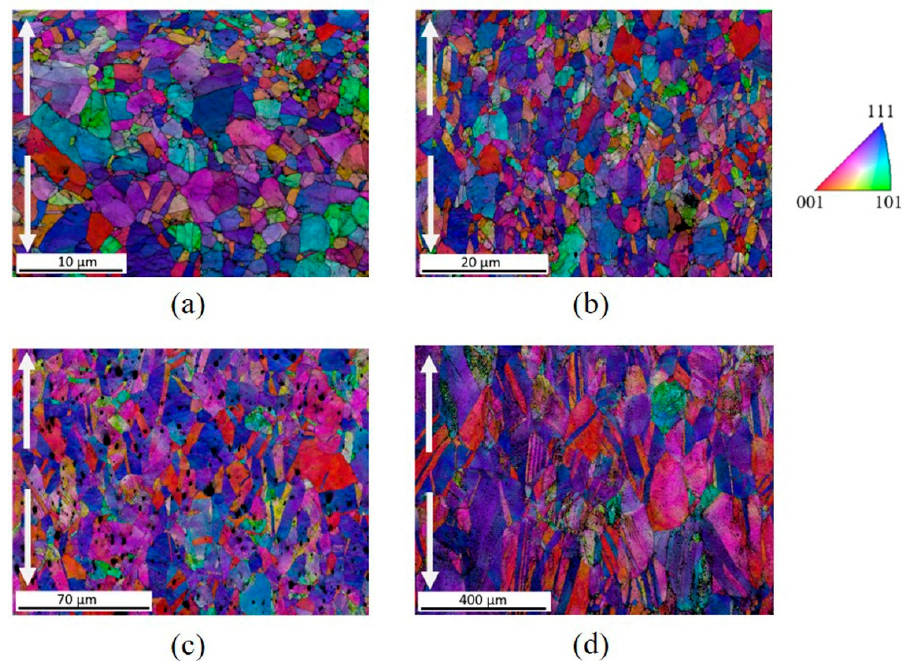
Figure 8. Superposition of inverse pole figure (IPF) + image quality (IQ) cartography for samples 1 (d = 0.82 µm) ( a ), 3 (d = 1.39 µm) ( b ), 4 (d = 4.0 µm) ( c ) and 5 (d = 25 µm) ( d ) with the tensile stress direction as reference, for fractured samples. White arrows indicate the tensile direction.